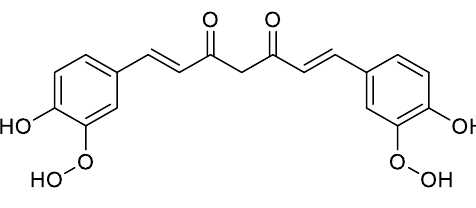
Figure 5. Structure of curcumin keto-form.